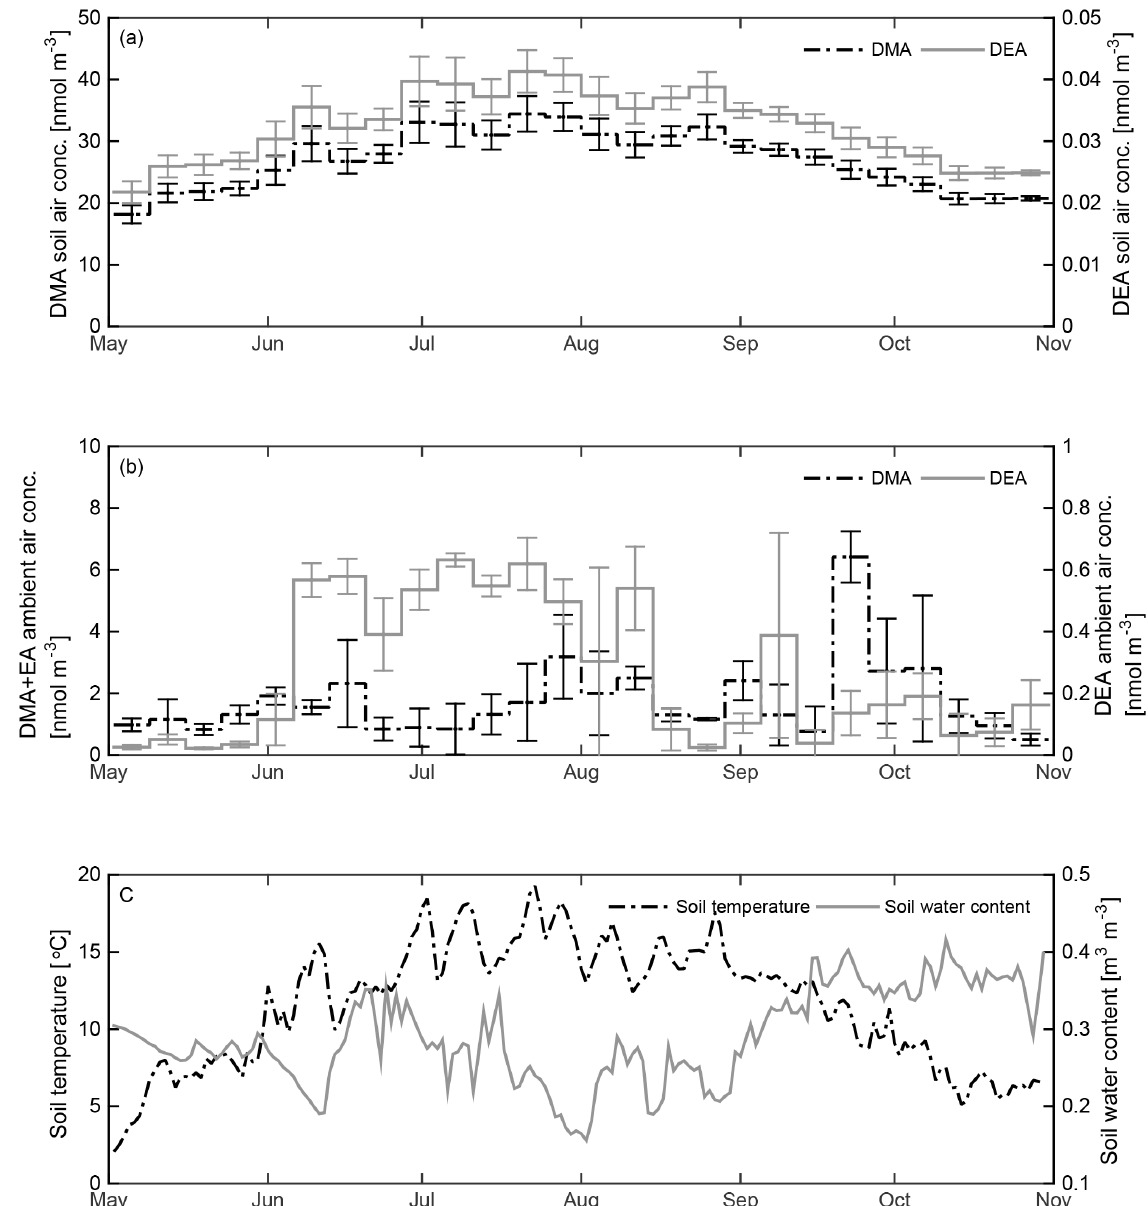
Figure 2. Estimated soil air concentrations of dimethylamine (DMA) and diethylamine (DEA) with their standard deviations at mean soil water pH of 5.3 (a) ; measured ambient air concentration of DMA + ethylamine and DEA (b) with their standard deviations redrawn from Kieloaho et al. (2013). In panel (c) , measured soil temperature and soil water content from May 2011 to October 2011 are shown. Table 2. Mean soil air concentrations and flux estimates for dimethylamine (DMA) and diethylamine (DEA) followed by their